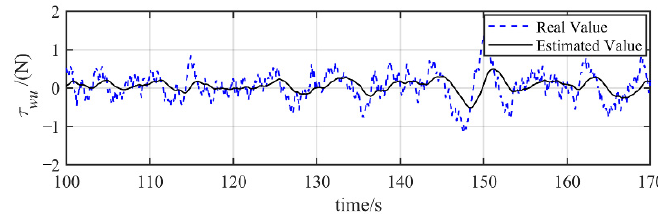
Figure 7. The estimated value of uncertain unknown τ wu .